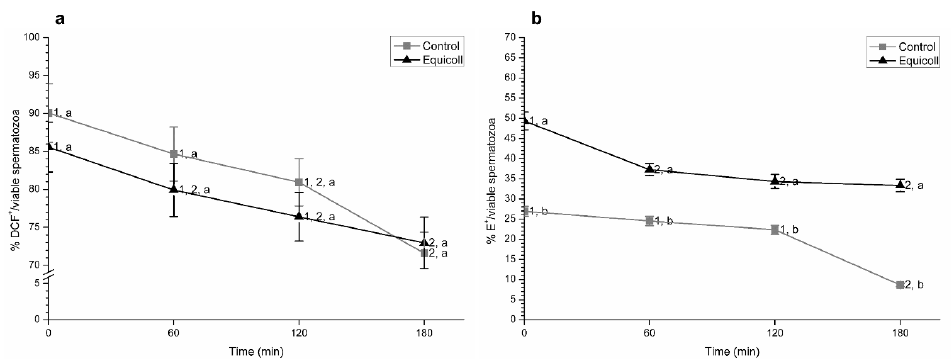
Figure 4. Proportions of viable spermatozoa with high intracellular levels of peroxides (DCF + ; a )